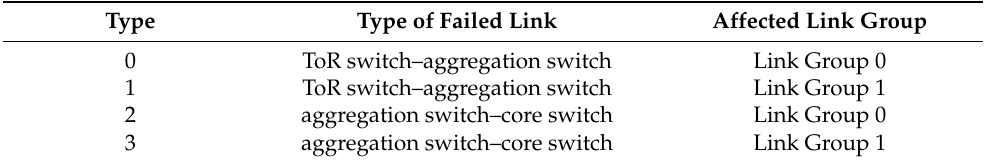
Table 2. Failure Types.